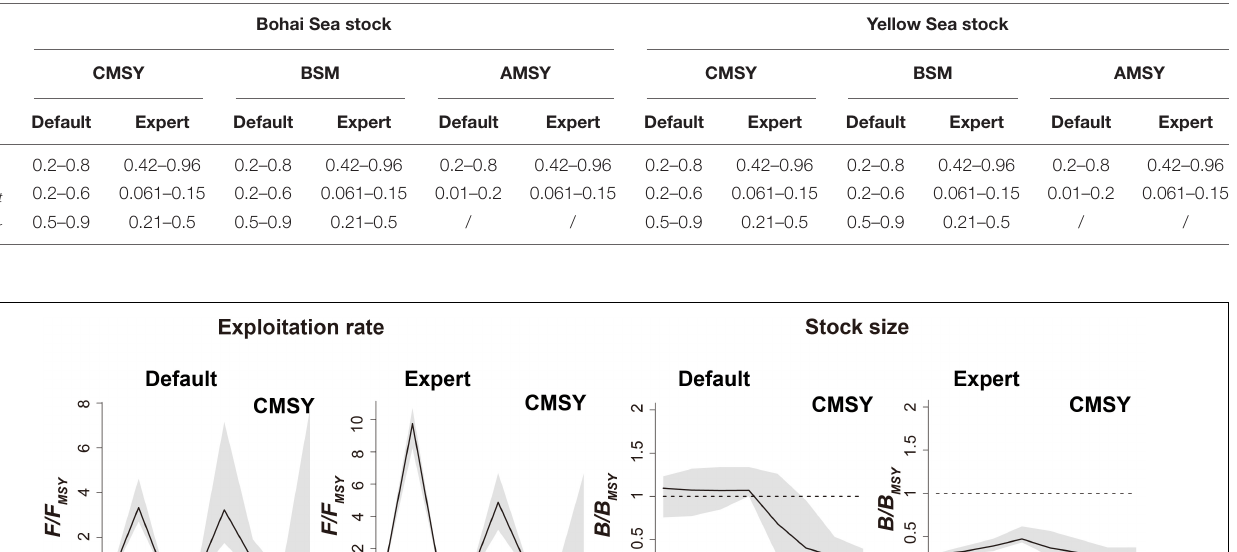
TABLE 2 | Prior ranges of r and B for Catch and Maximum Sustainable Yield (CMSY), Bayesian Schaefer model (BSM), and Abundance Maximum Sustainable Yield (AMSY).